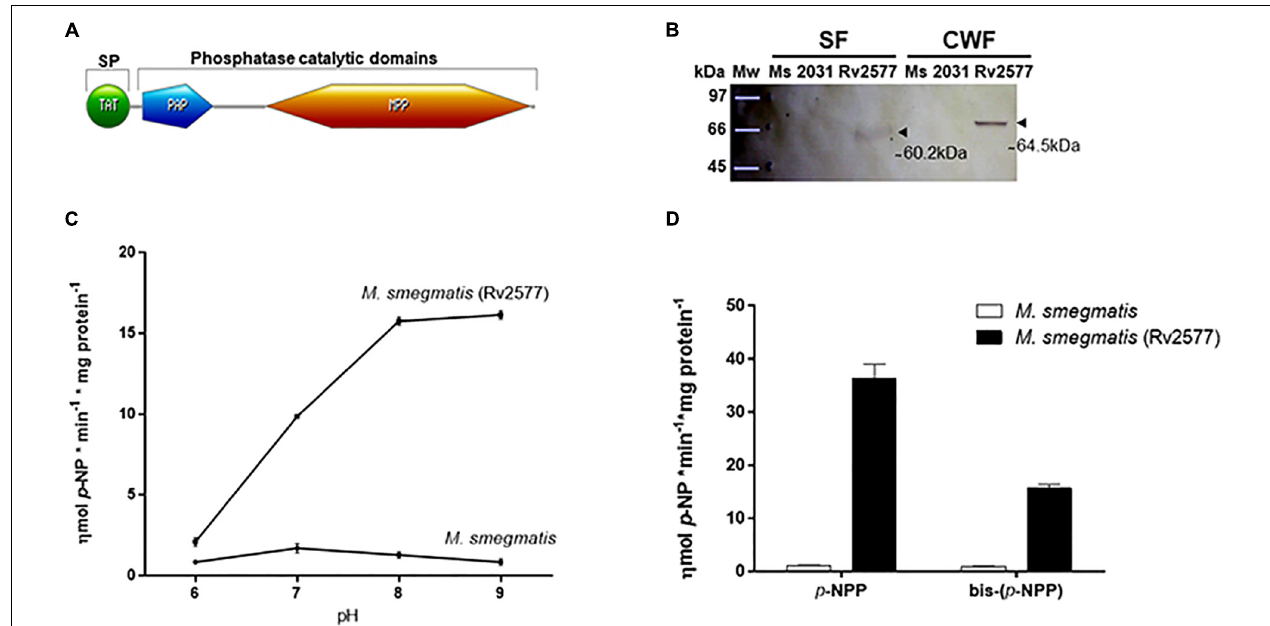
FIGURE 1 | Rv2577 is an HMW alkaline phosphatase and phosphodiesterase enzyme detected mainly in the cell wall of mycobacteria. (A) Scheme of the Rv2577 primary sequence with its conserved domains: the Twin arginine translocation (TAT) signal peptide (SP) (1–52 residues), the purple acid phosphatase N-terminal domain (PAP, 67–150 residues) and the metallophos (MPP)/Calcineurin-like phosphoesterase domain (215–513 residues). According to Pfam database, these last two domains represent the phosphatase catalytic signature. (B) Western blot (WB) analysis with α -HA antibody showing the subcellular localization of Rv2577 in the soluble cytosolic and membrane (SF) or cell wall (CWF) fractions from M. smegmatis that overexpress the Rv2577-HA-His fusion protein (Rv2577). The same amount of total protein was loaded per lane, separated by SDS-PAGE and then transferred for WB analysis. The arrows indicate two reactive bands of ∼ 60.2 kDa (soluble isoform) and ∼ 64.5 kDa (cell wall isoform). M. smegmatis wild type (Ms) and M. smegmatis with the empty pML2031 vector (2013) were used as negative controls. (C) Phosphatase activity of Rv2577 in the soluble fraction from M. smegmatis wild type (M. smegmatis) and M. smegmatis overexpressing the Rv2577 protein [ M. smegmatis (Rv2577)] at 6, 7, 8, or 9 pH with p -NPP as substrate. (D) Phosphatase and phosphodiesterase activities of IMAC-Ni + 2 -purified rRv2577 protein (black bars) and IMAC-Ni + 2 purified proteins from M. smegmatis (white bars) at 8 pH with the artificial p -NPP or bis-( p -NPP) substrates, respectively. Graphs (C,D) represent the results obtained in three independent experiments performed in duplicate.